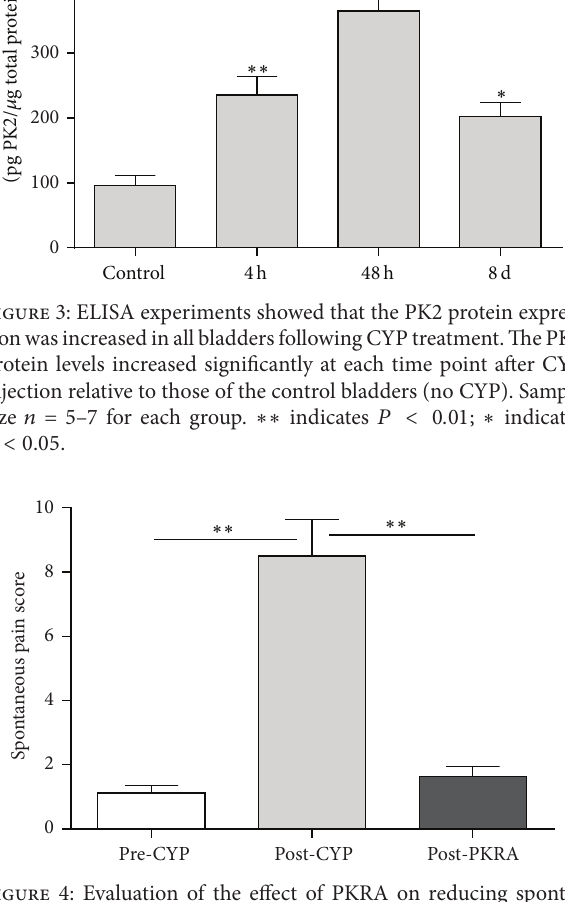
Figure 4: Evaluation of the effect of PKRA on reducing sponta- neous visceral pain evoked by CYP treatment in rats. Intravesical administration of PKRA (1 𝜇 M) significantly reduced spontaneous pain in rats with 48 h duration of CYP-induced cystitis. ∗∗ indicates 𝑃 < 0.01 . Sample size 𝑛 = 6 for each